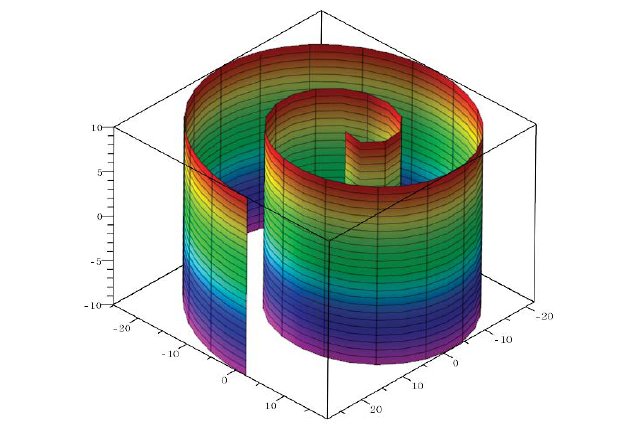
Figure 2. The cylindrical surface in Example